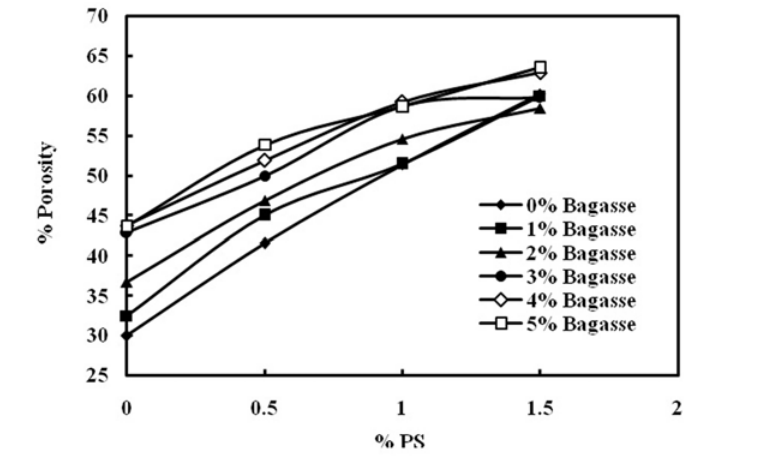
Figure 8. Effect of percent PS and Bagasse addition to percent porosity A plot of the reciprocal of fractional porosity against the reciprocal of fractional water absorption should yield a straight line of slope = ρ W and intercept = 1. Actually such a plot when performed resulted in a straight line as ρ S shown in Figure (9).